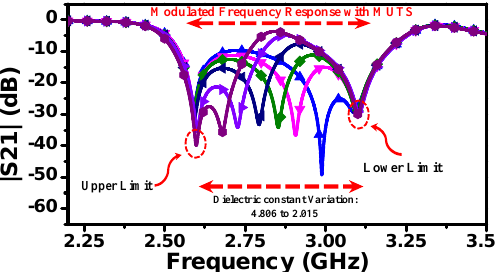
Figure 6. The scattering parameter | S 21 | of the microwave intelligent sensing (MIS) obtained using HFSS, where the resonators A and C are loaded by dielectric materials with the relative permittivity of 4.806 and 2.015, respectively, while resonator B is loaded by the dielectric material with permittivity of 3.215.